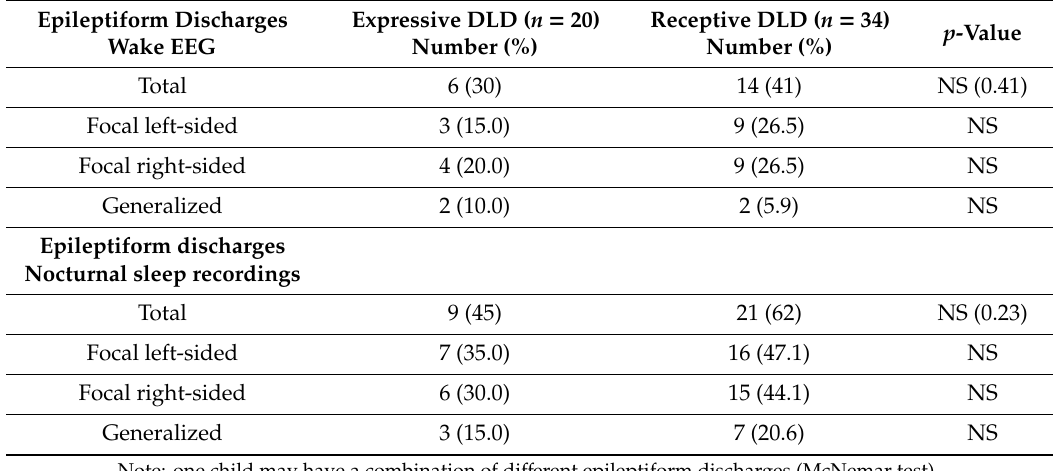
Table 3. Epileptiform discharges: Wake EEG and overnight sleep EEG / PSG in receptive and expressive form of DLD ( n =